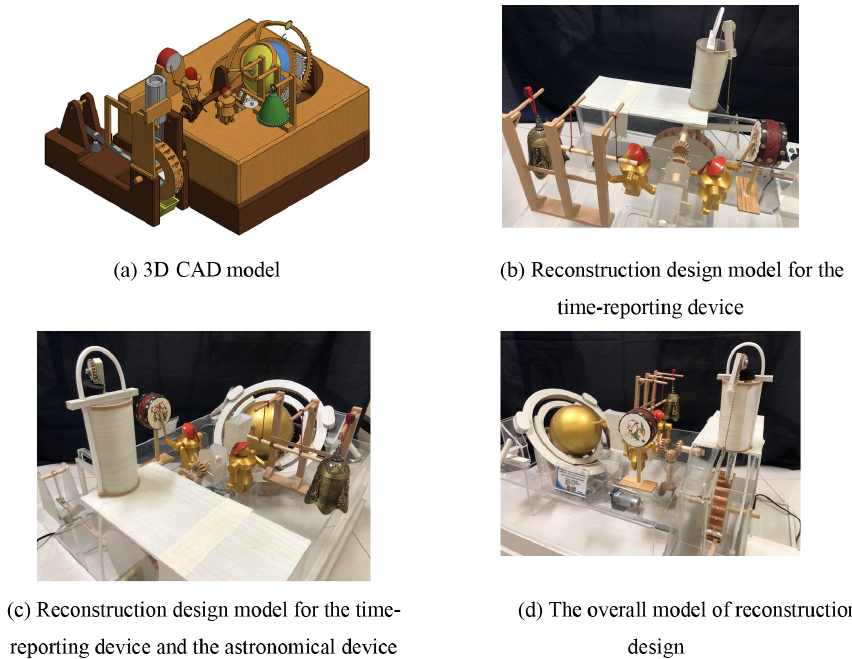
Figure 25. Reconstruction design and of the physical model I-M1